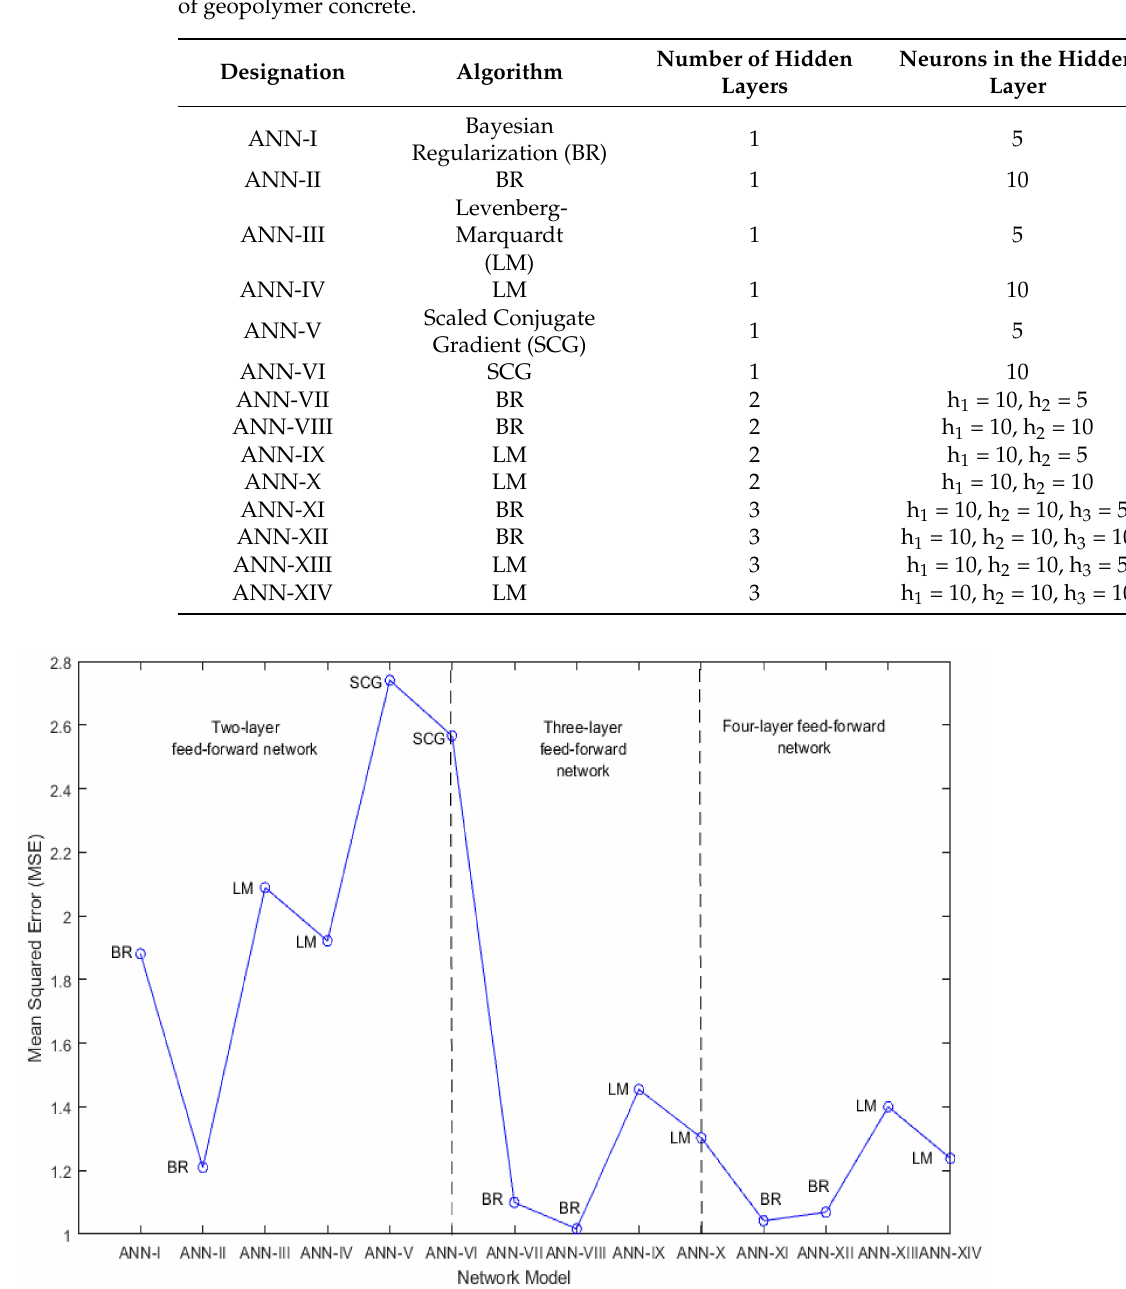
Figure 5. Mean squared error (MSE) performance comparison of two, three- and four-layer feedforward network